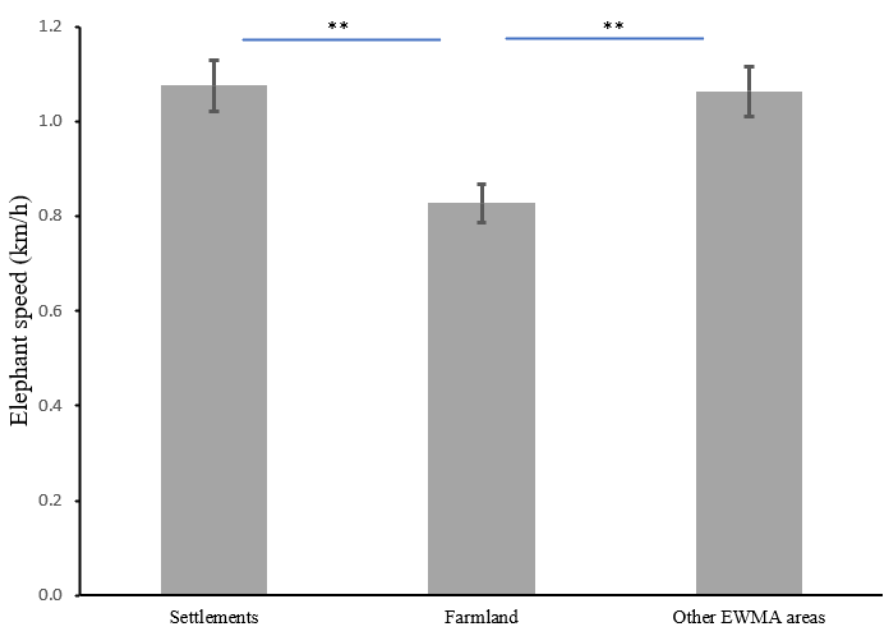
Figure 4. Home ranges for three collared male elephants ( n = 52,488) in the EWMA and close farm- lands adjacent to the southern part of EWMA from July 2019 to September 2020 calculated using Kernel Density Estimation (KDE).